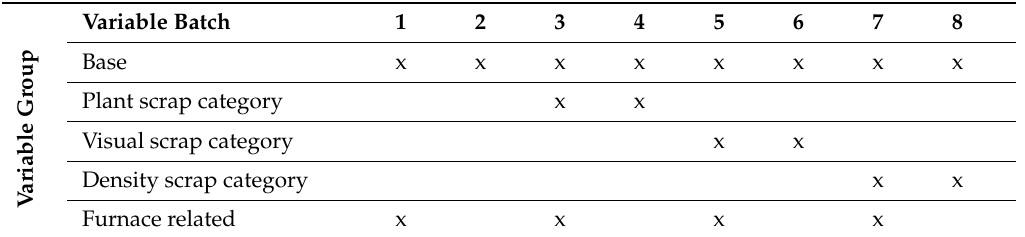
Table 3. The domain-specific variable batches. The variables present in each variable group are shown in Table 4.